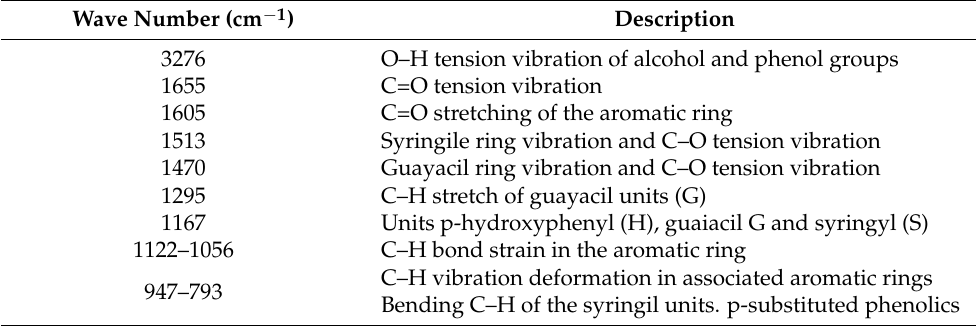
Table 6. Main absorption bands found in the FTIR spectra of lignin organosolv from sorghum.